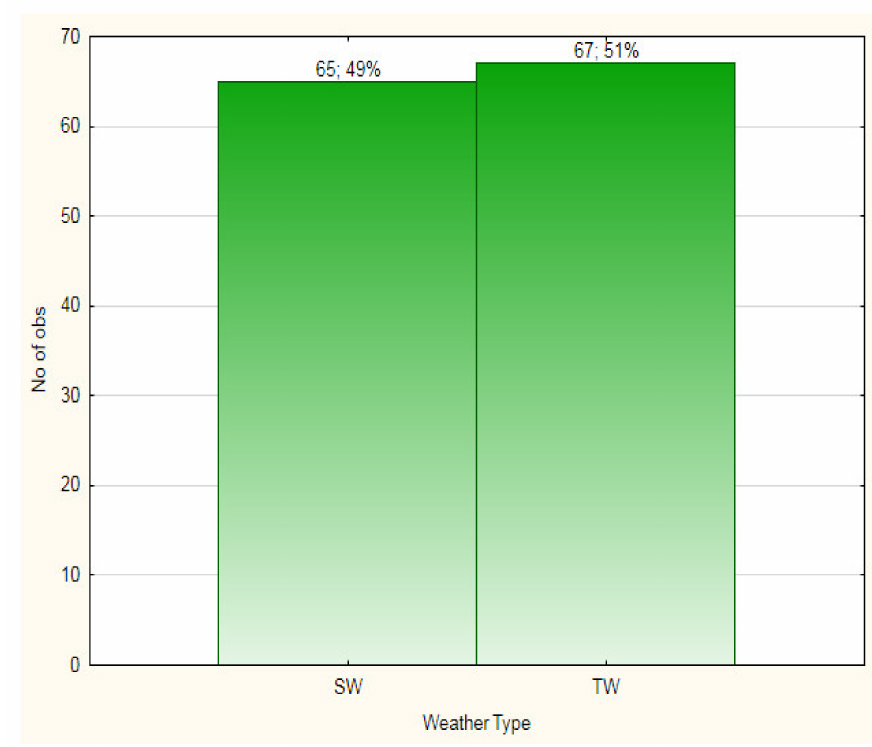
Figure 8. The ratio between Space Weather (SW) and Terrestrial Weather (TW) that which differ when corresponding to different medical events in all the Maximal Difference Days of 15 calendar seasons and were common for the both gender groups.